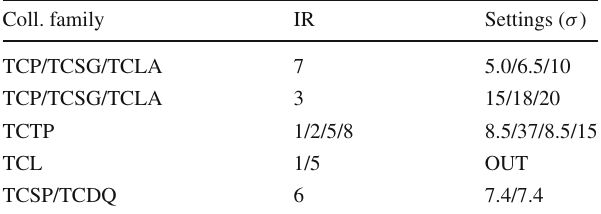
Table 4 LHC collimation settings in 2018, which are expressed in units of RMS beam size ( σ ), assuming a gaussian beam distribution and normalised emittance ε ∗ = 3 . 5 μ m